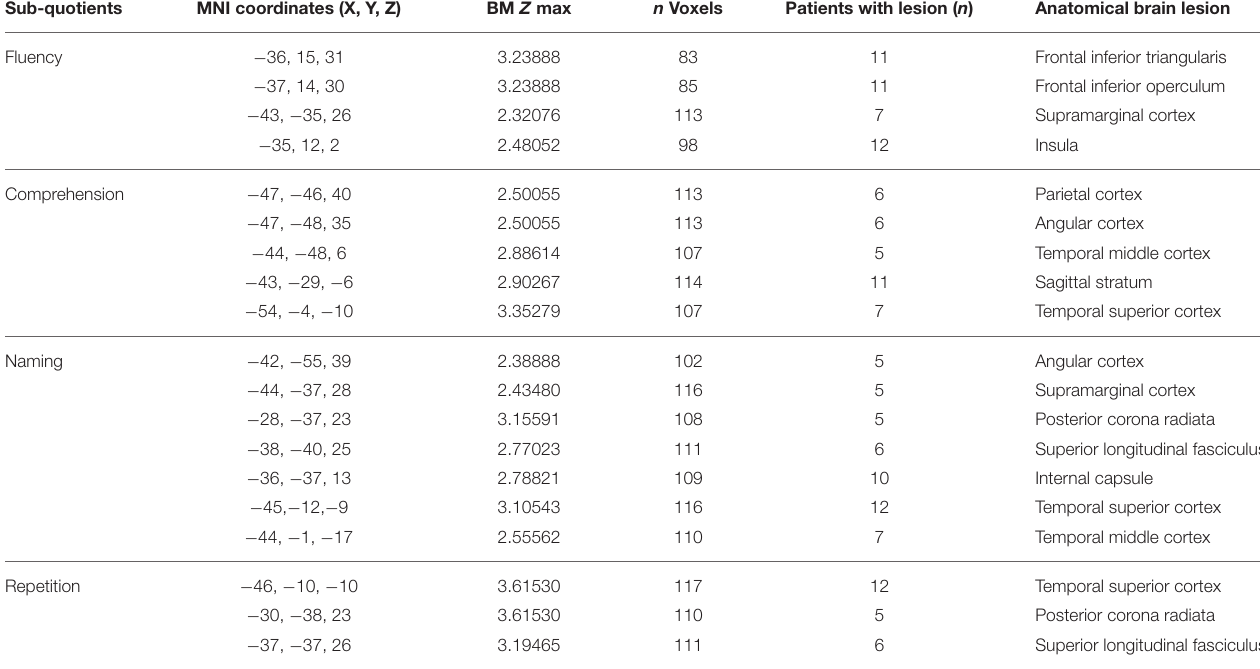
TABLE 3 | Stroke lesions associated with the aphasia dimensions. Sub-quotients MNI coordinates (X, Y, Z) BM Z max n Voxels Patients with lesion ( n ) Anatomical brain